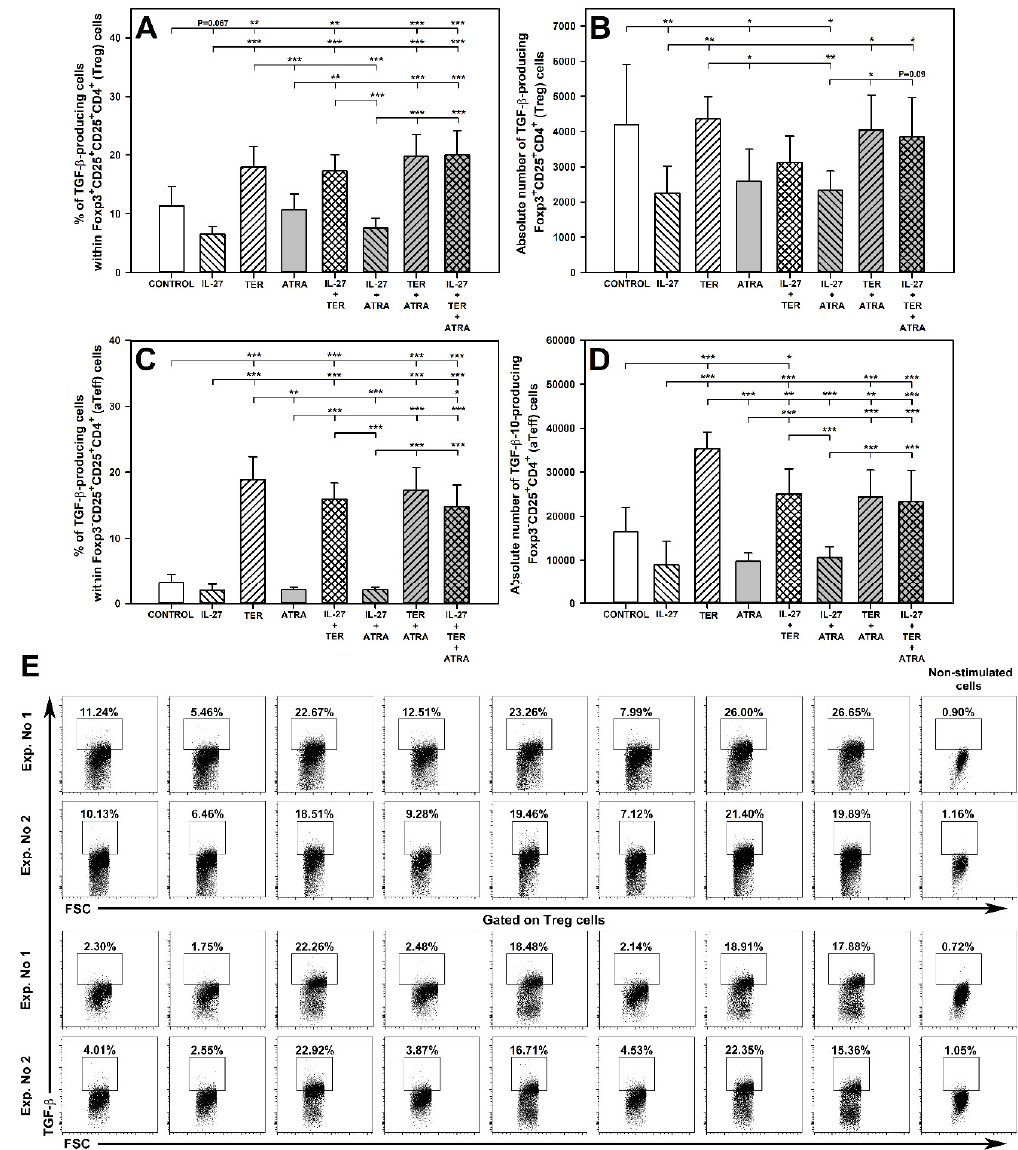
Figure 8. Effect of IL-27, teriflunomide (TER), all-trans-retinoic acid (ATRA), and their combinations on the number of TGF-β-producing Foxp3 + CD25 + CD4 + and Foxp3 − CD25 + CD4 + T cells, i.e., regulatory (Treg) and activated effector (aTeff) T cells, respectively. The relative ( A , C ) and absolute count ( B , D ) of particular cell subsets were determined in cell cultures incubated in the absence (CONTROL) and presence of IL-27 (100 ng/mL), TER (10 −4 M), and ATRA (10 −6 M) for 72 h including concomitant stimulation with IL-2, anti-CD3, and anti-CD28 and re-stimulation with PMA and ionomycin for the last 5 h before harvest. Unstimulated cells served as a negative control for the cell activation. The relative count is expressed as a percentage of TGF-β-producing cells within Foxp3 + CD25 + CD4 + ( A ) and Foxp3 − CD25 + CD4 + ( C ) T cell subsets. The absolute count represents the number of TGF- β + Foxp3 + CD25 + CD4 + ( B ) and TGF-β + Foxp3 − CD25 + CD4 + ( D ) T cells per sample well. Results are ex- pressed as the mean (± S.D.) of two independent experiments with four mice per experiment (overall n = 8, * p < 0.05, ** p < 0.01, *** p < 0.001). Examples of dot plot cytograms showing the distribution of TGF-β-producing cells within Foxp3 + CD25 + CD4 + ( E , upper panel) and Foxp3 − CD25 + CD4 + ( E , lower panel) T cell subsets.